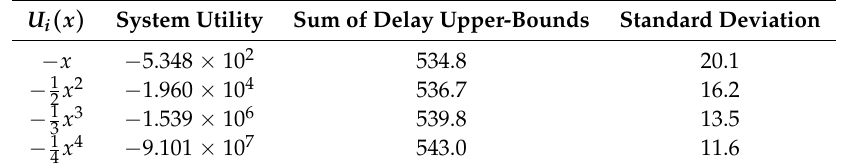
Table 2. The system utility, assigned intermediate deadline sum (i.e., total delay upper-bound) and standard deviation, with different utility functions, by the cooperative framework in Section